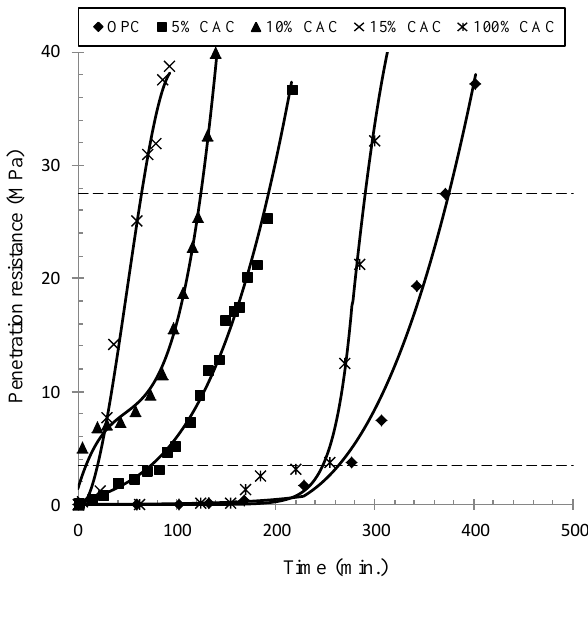
Figure 2. Penetration resistance of fresh concrete with time to determine the setting